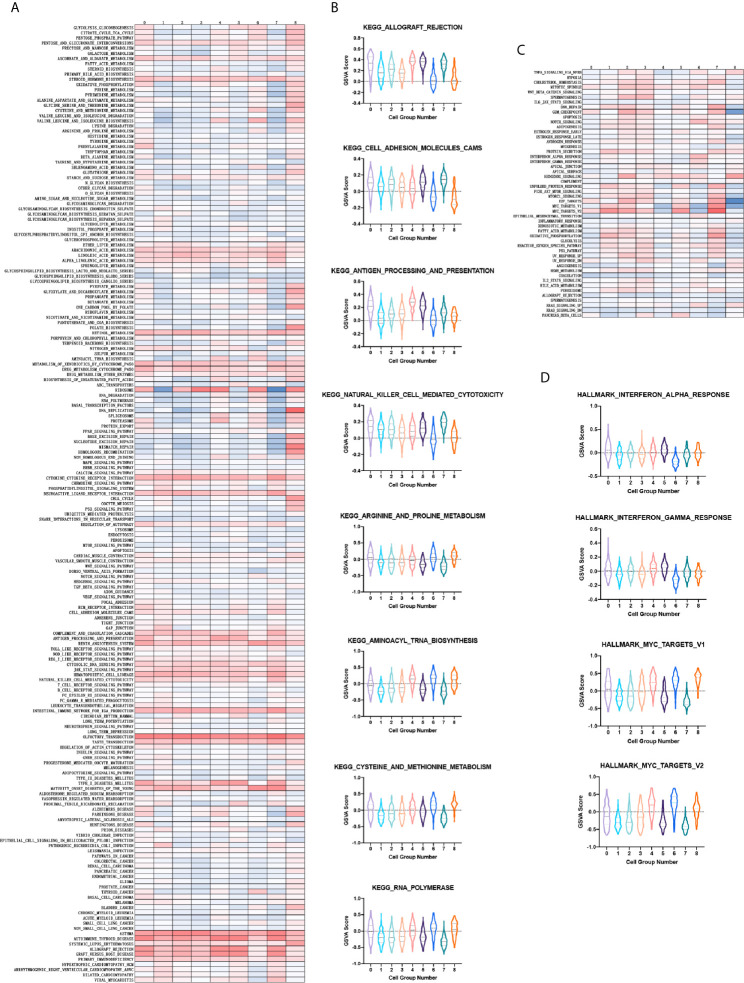

(A) Heatmap showing the gene set variation analysis (GSVA) scores of each cell cluster in the KEGG pathway. (B) Violin plot depicting the GSVA score of specific KEGG pathways in each cell cluster. (C) Same as A in H collection in molecular signature database (MsigDB). (D) Same as B in H collection in MsigDB.